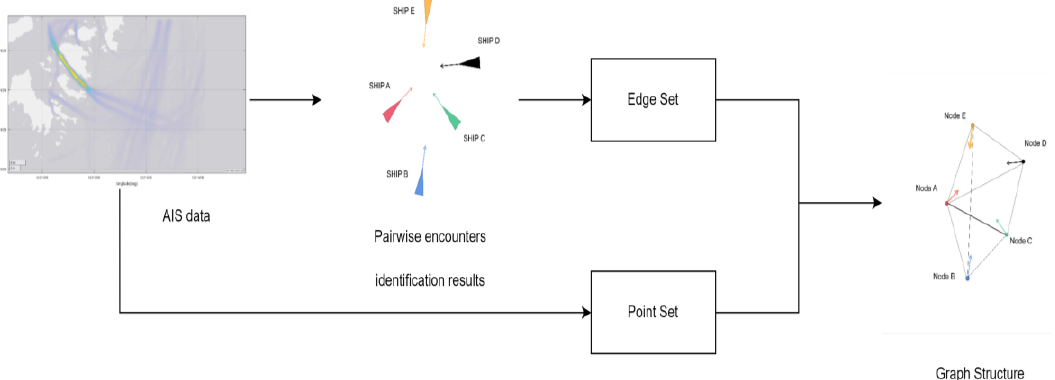
Figure 9. The identification flow of multiple ship encounters.